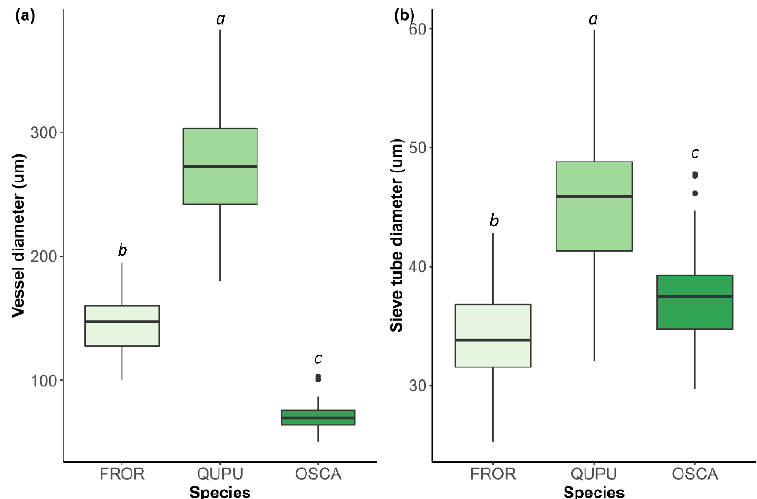
Figure 4. Characteristics of conduits: ( a ) tangential diameter of initial earlywood vessels; ( b ) tangential diameter of early phloem sieve tubes in Fraxinus ornus (FROR), Quercus pubescens (QUPU) and Ostrya carpinifolia (OSCA) in Podgorski Kras in 2019.